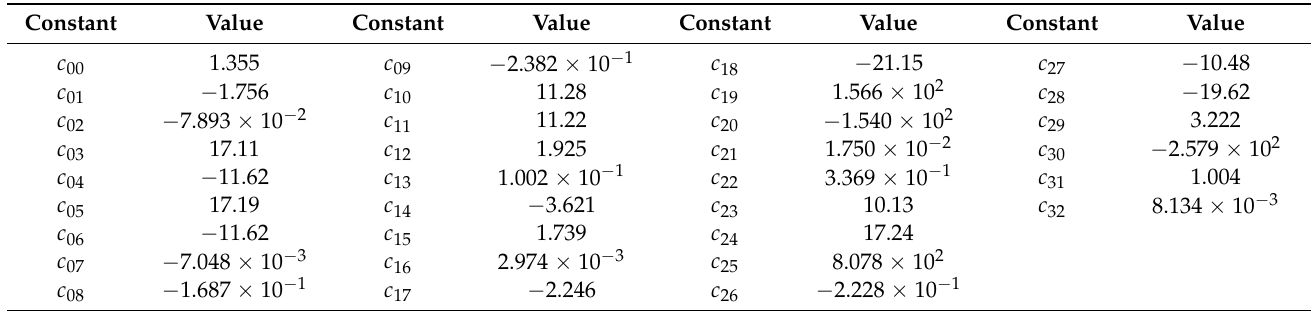
Table A3. Rounded values of the constant for Equation (3).